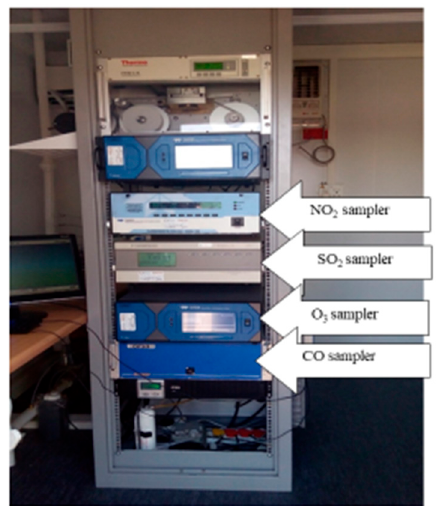
Figure 2. CO, NO 2 , SO 2 , and O 3 samplers.